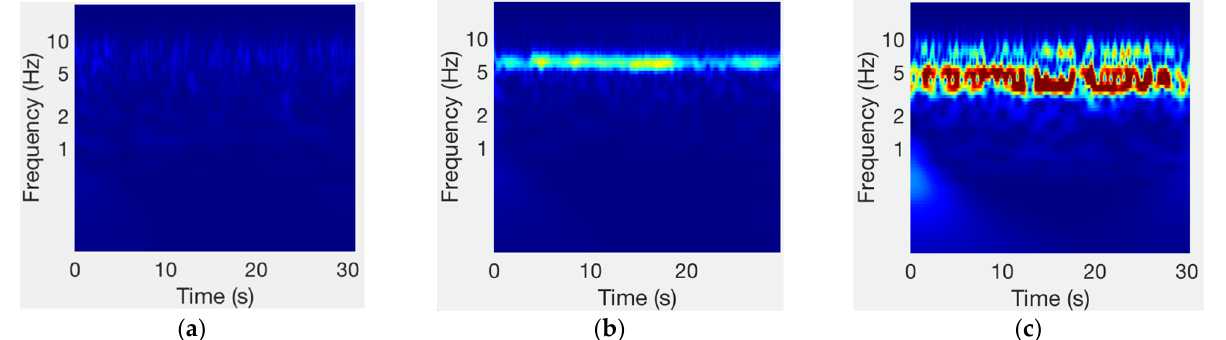
Figure 9. Spectrum of accelerometer signals for different tremor severities: ( a ) no tremor (UPDRS = 0); ( b ) slight tremor (UPDRS = 1); ( c ) mild tremor (UPDRS = 2).